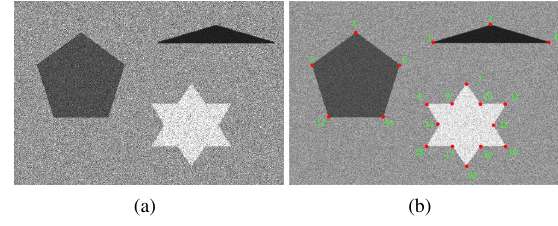
Figure 3. (a) The simulated three-look SAR image. (b) The ground truth map.